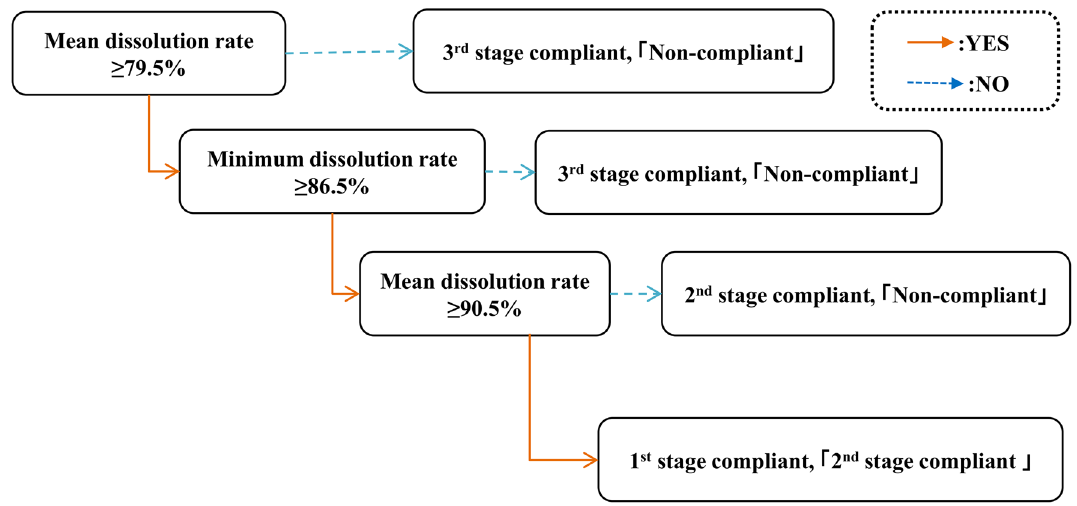
Figure 3. Style tree dendrogram for using the combination of average dissolution rate and minimum dissolution rate as the compliance